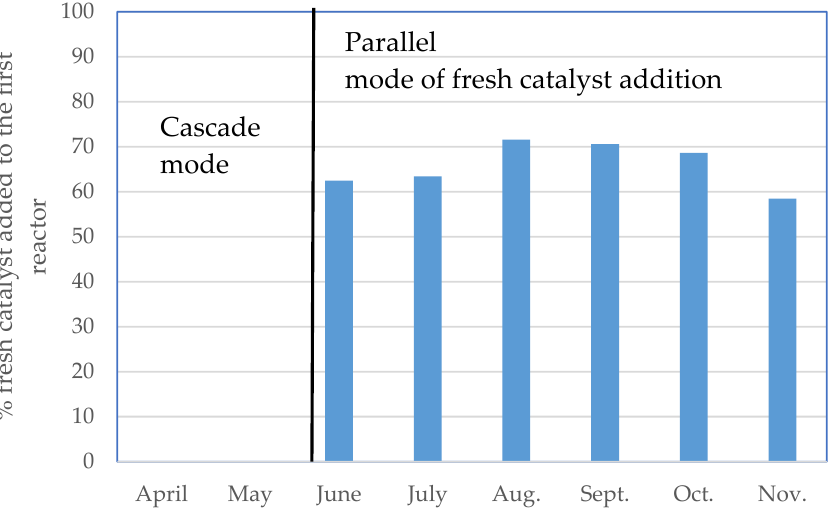
Figure 11. Per cent of the fresh catalyst added in the first ebullated bed reactor relative to the total fresh catalyst added in both reactors.